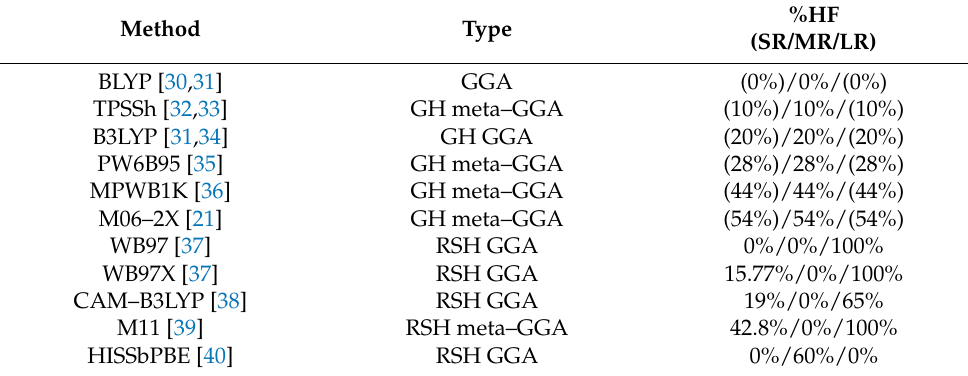
Table 3. List of functionals tested within the